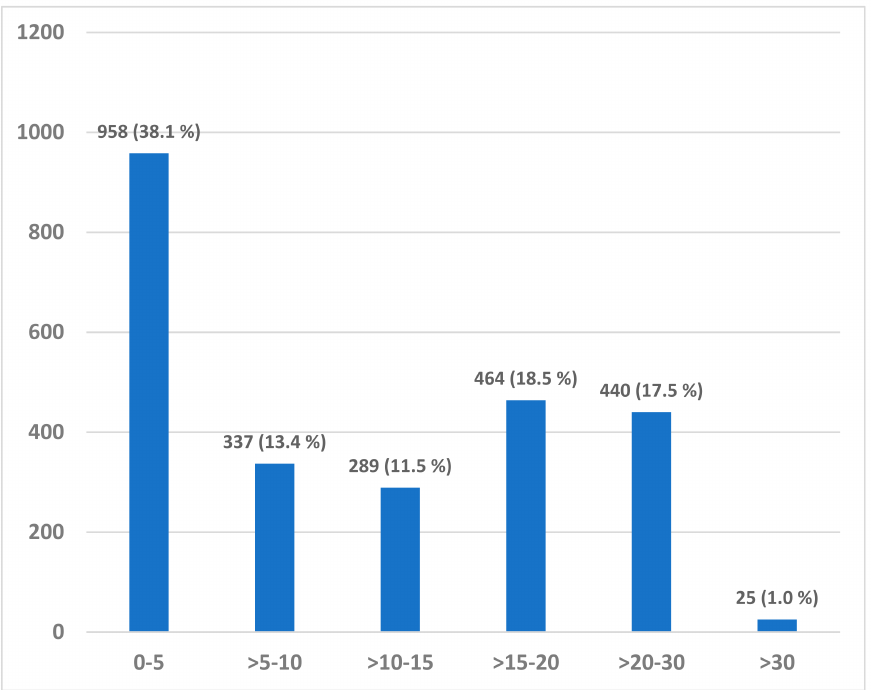
Figure 6. The number of subjects with an accumulated day 7 drift in seconds divided into six categories (0–5, >5–10, >10–15, >15–20, >20–30 and >30